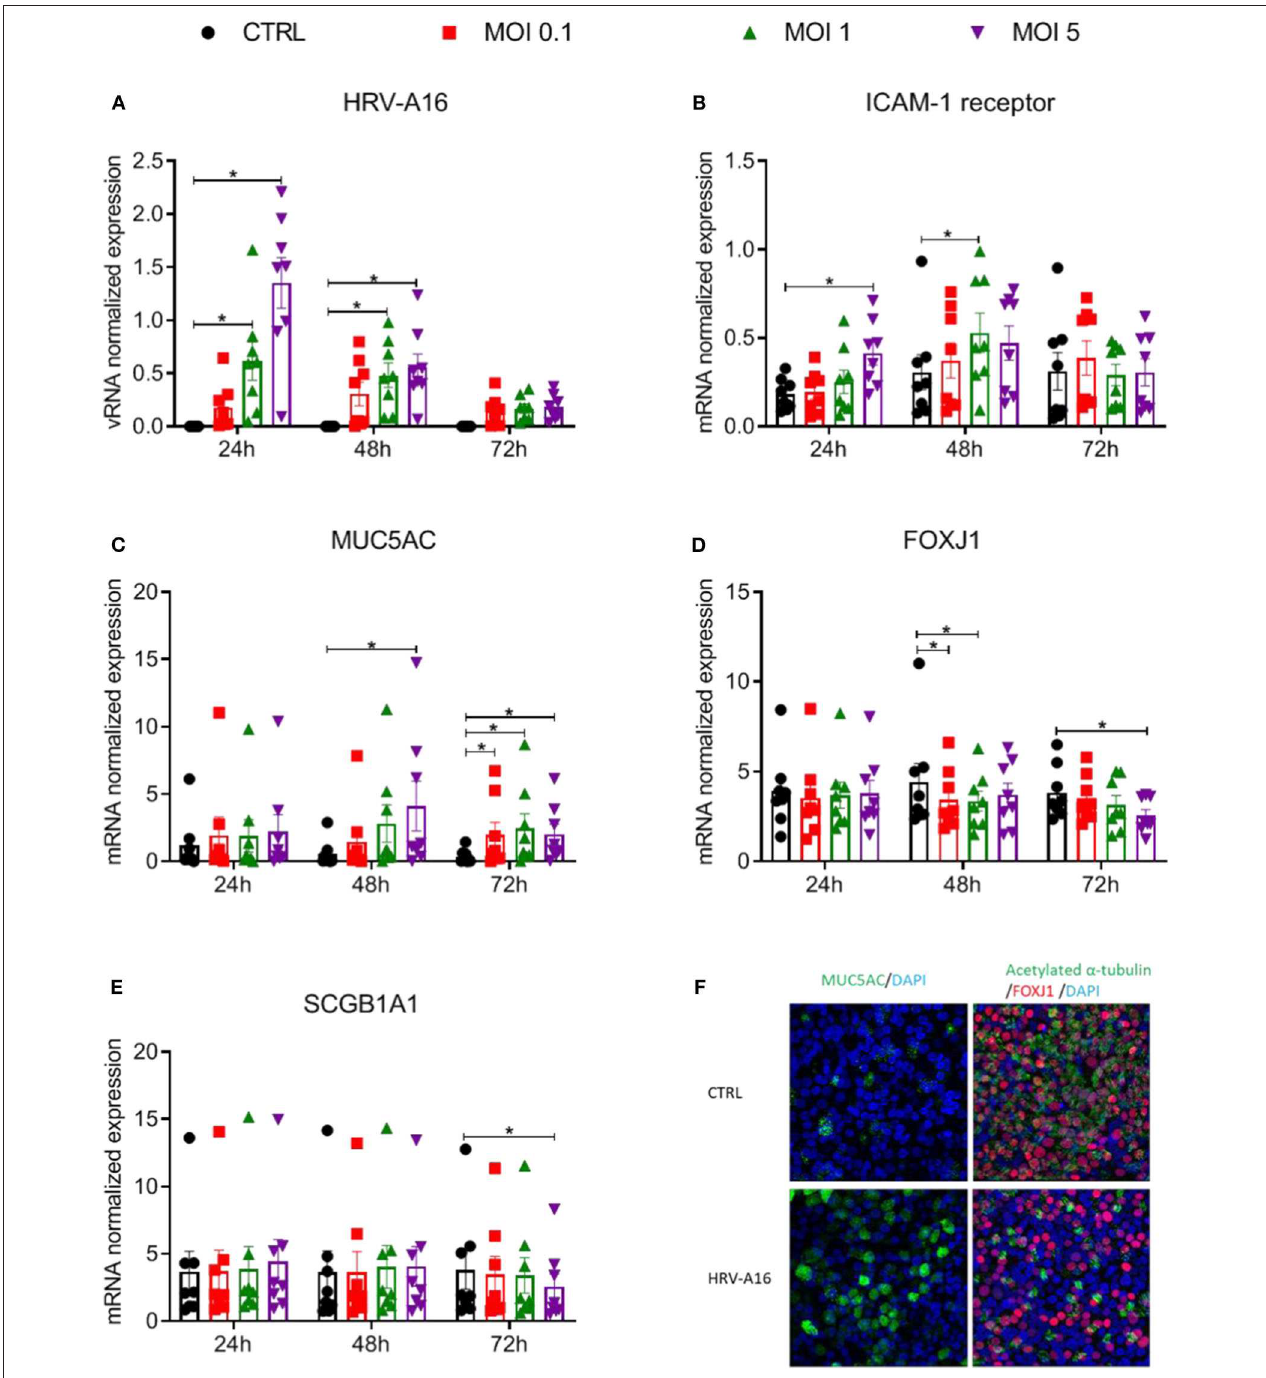
FIGURE 1 | Effects of epithelial infection by HRV-A16 on its receptor and epithelial cell markers ALI-PBEC were infected with HRV-A16 (MOI 0.1, 1, 5) for 1h and were incubated for 24, 48, or 72h. (A–E) The replication of HRV-A16 vRNA and gene expression of ICAM-1, MUC5AC, SCGB1A1, and FOXJ1 were measured by qPCR. Data are shown as target gene expression normalized for RPL13A and ATP5B. Data are mean values ± SEM. n = 8 independent donors. Analysis of differences was conducted using two-way ANOVA with a Tukey post-hoc test. Significant differences are indicated by * P < 0.05 compared with control. (F) At 48h after HRV-A16 infection, cells were fixed in 4% paraformaldehyde solution and stained using immunofluorescence with primary antibodies against MUC5AC (goblet cell markers, green) or acetylated α -tubulin and FOXJ1 (ciliated cell markers, green, and red) in combination with 4 ′ ,6-diamidino-2-phenylindole (DAPI) for nuclear staining (blue). Images shown are representative for results obtained with cells from four different donors with 630 x original magnification ( n = 4).